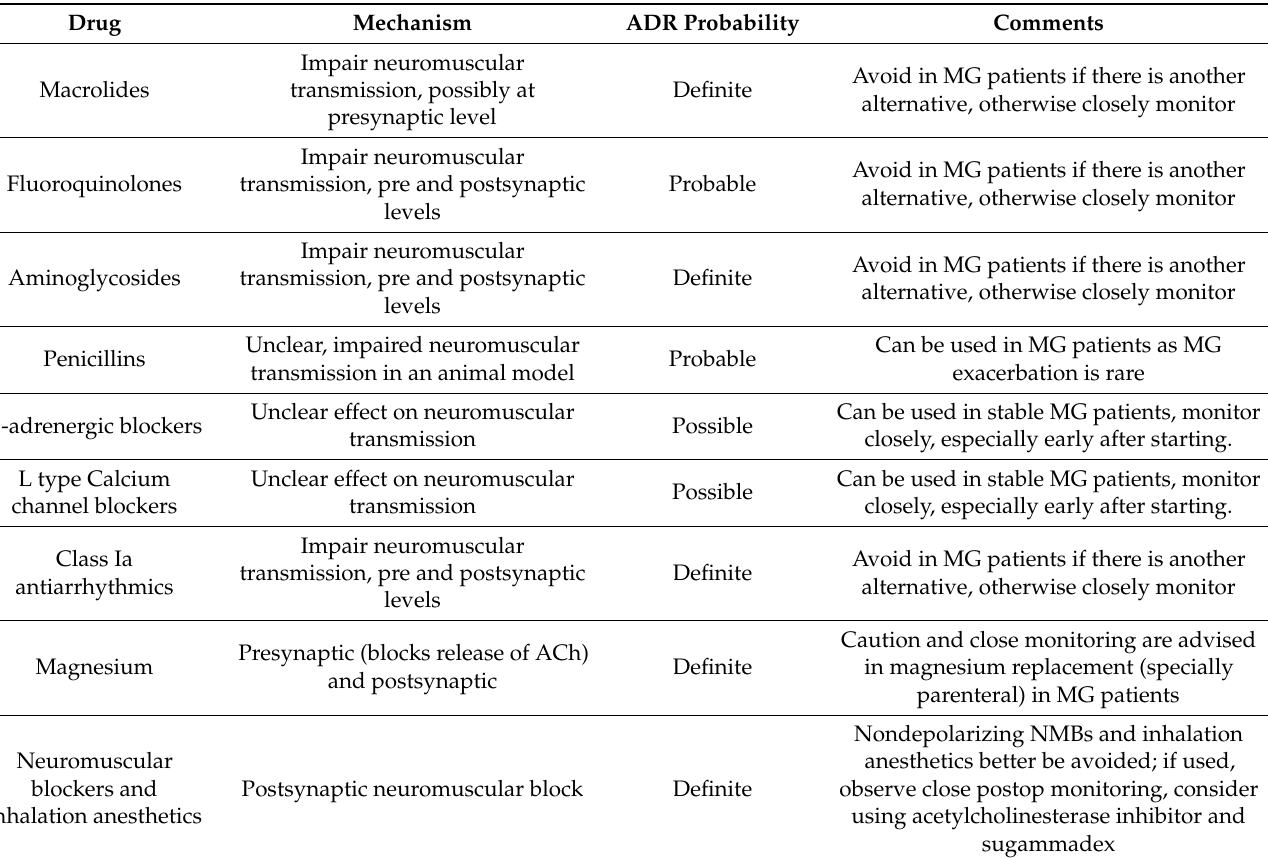
Table 2. Drugs associated with MG-like symptoms, unmasking and exacerbation of MG, through their adverse effect on neuromuscular